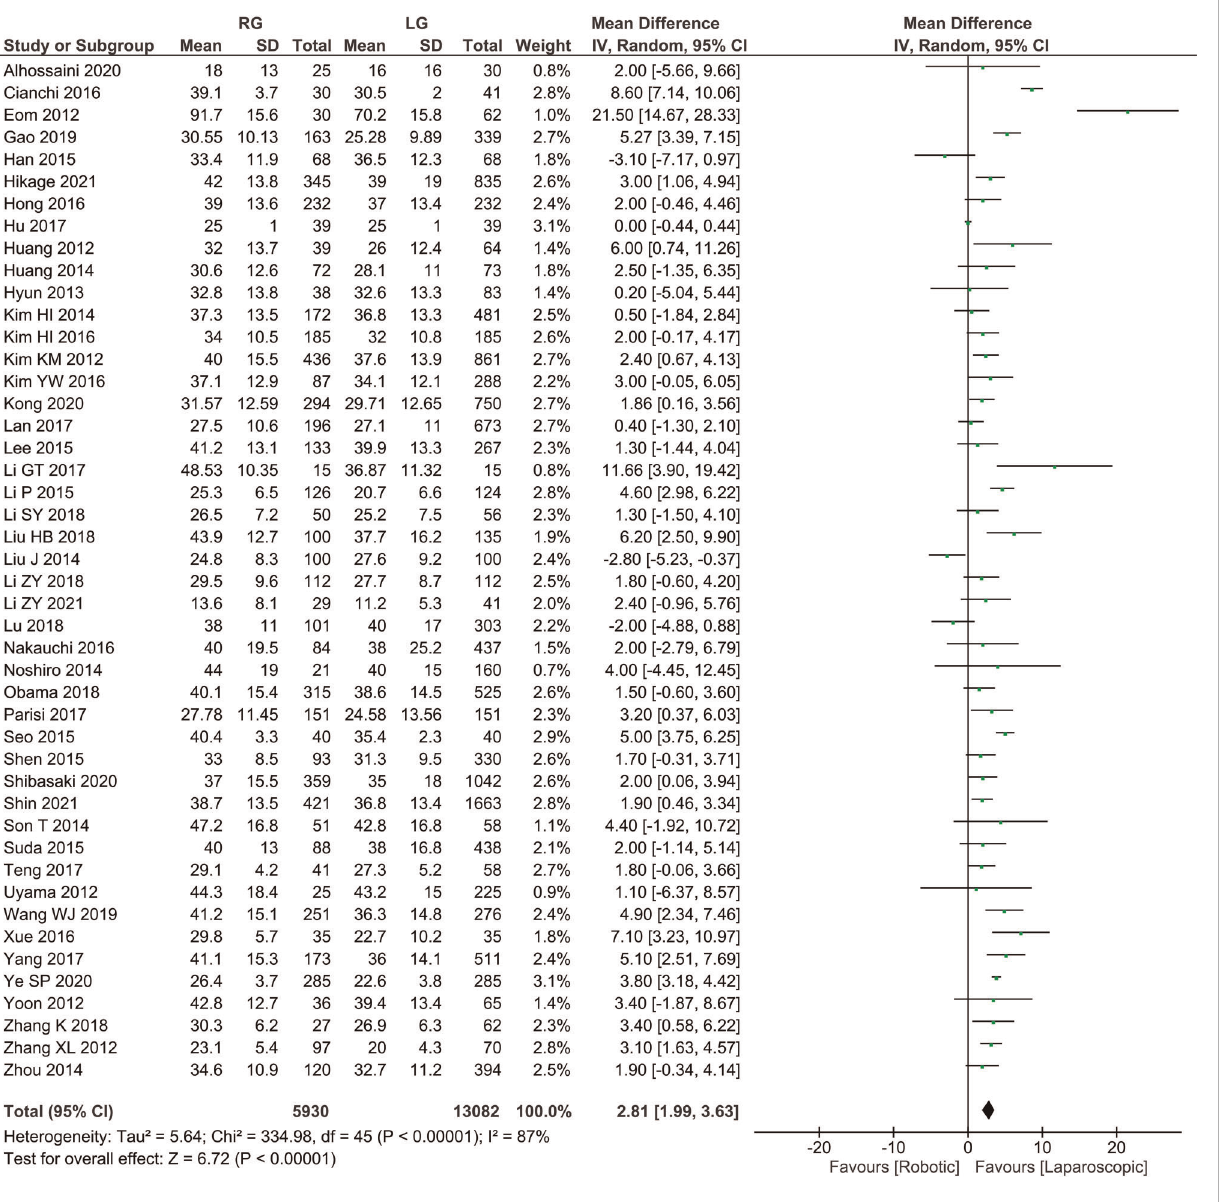
FIGURE 3 | Comparison of the number of resected lymph nodes between RG and LG